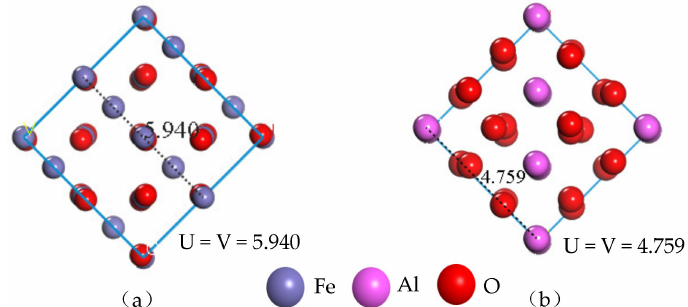
Figure 3. Lengths of the original unit cell cut surface U and V: ( a ) Fe 3 O 4 surface model, ( b ) Al 2 O 3 surface model.